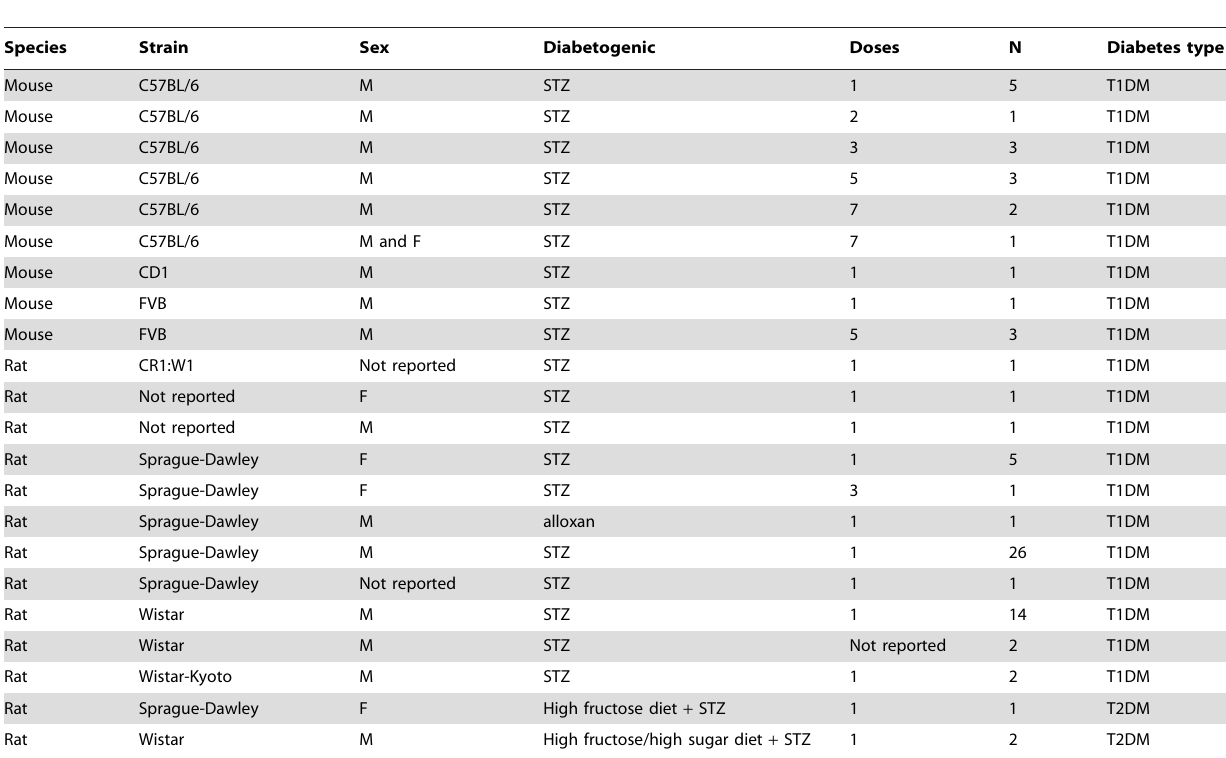
Table 3. Summary of dosing regimens used to induce experimental diabetes in rodents.